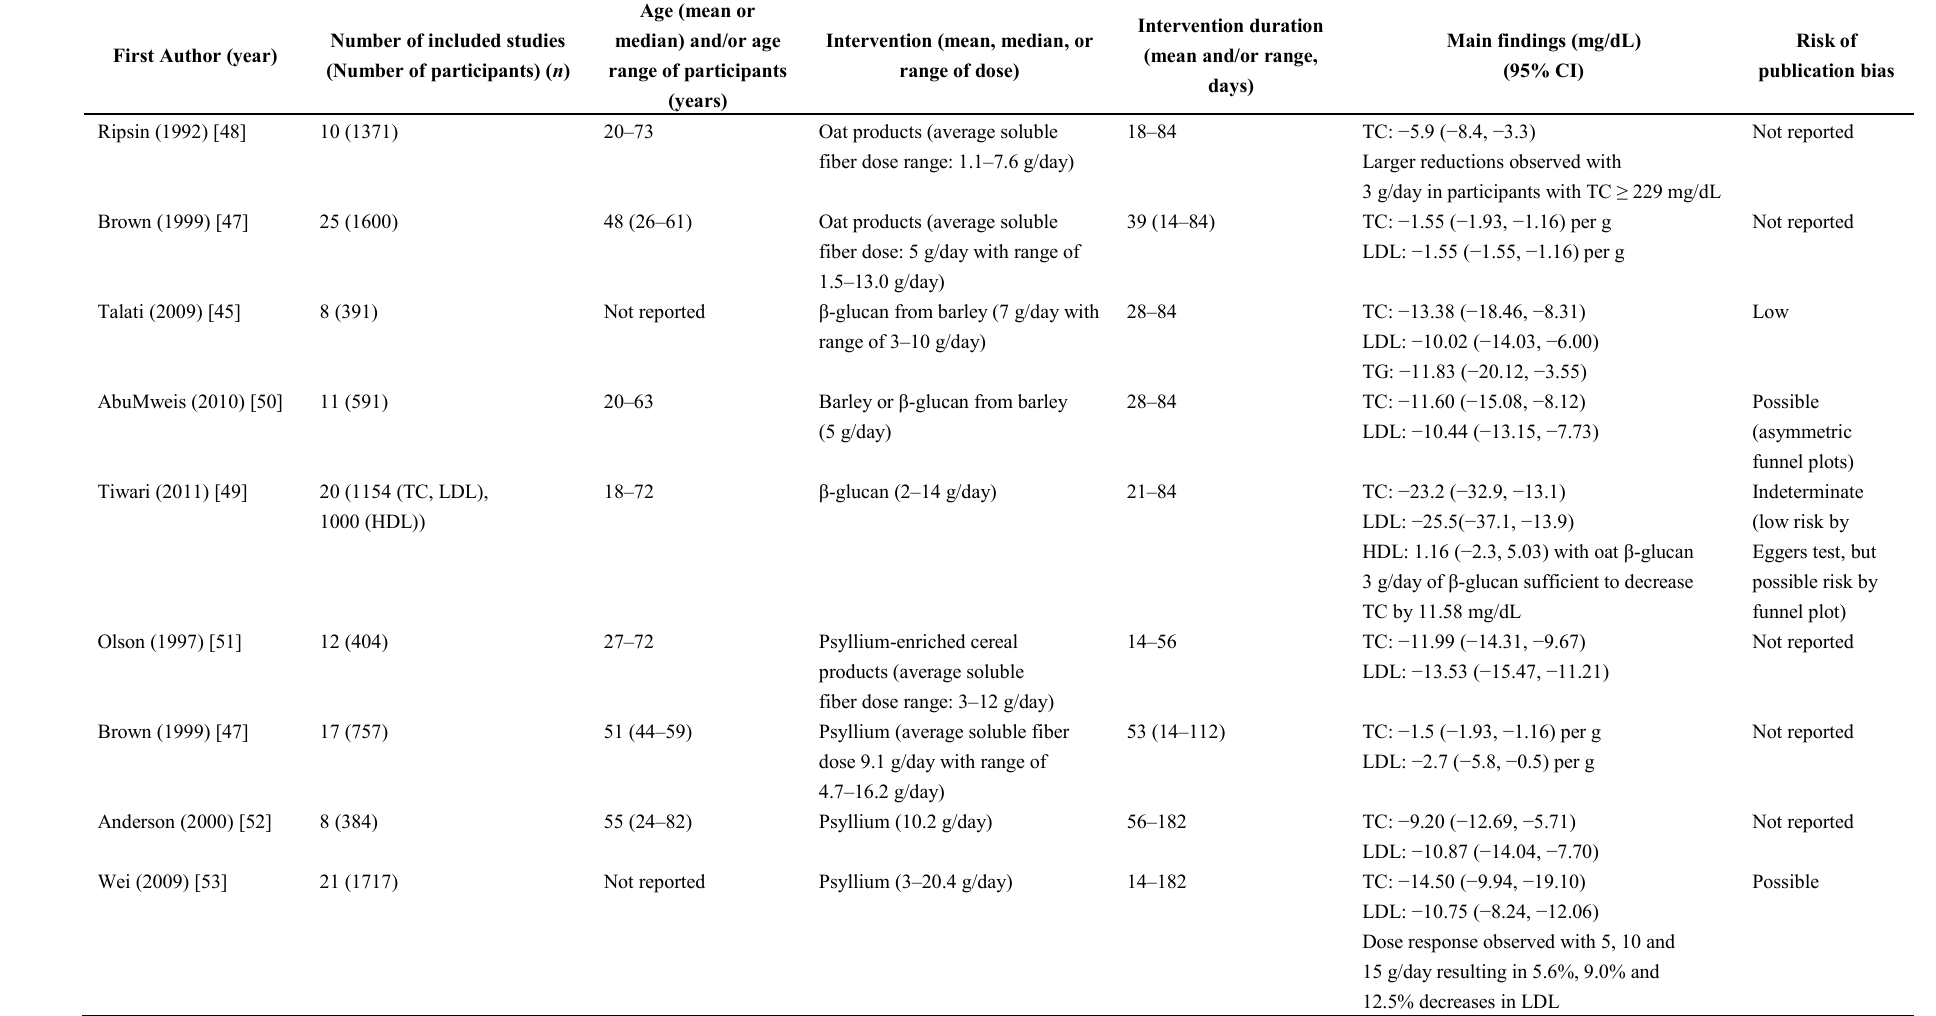
Table 2. Meta-analyses on β-glucans and psyllium in relation to serum